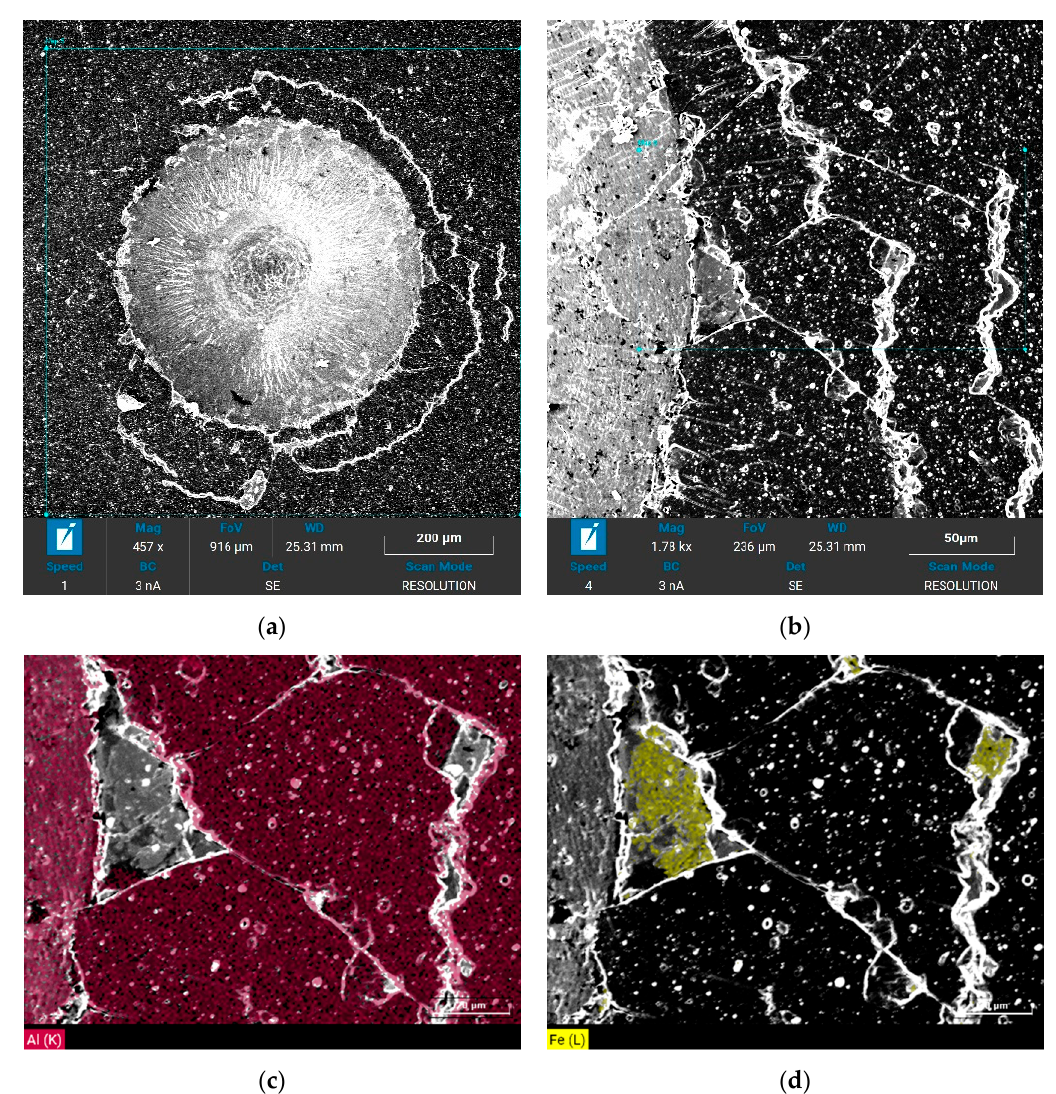
Figure 9. EDS analysis of cracks and the peeled AlCrVN coating: ( a ) surface feature of the indentation; ( b ) surface feature of the cracks and spallation; ( c ) distributions of Al; ( d ) distributions of Fe.